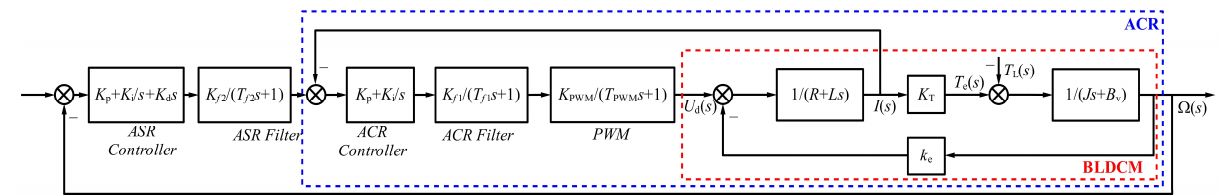
Figure 8. BLDCM control system transfer function structure.